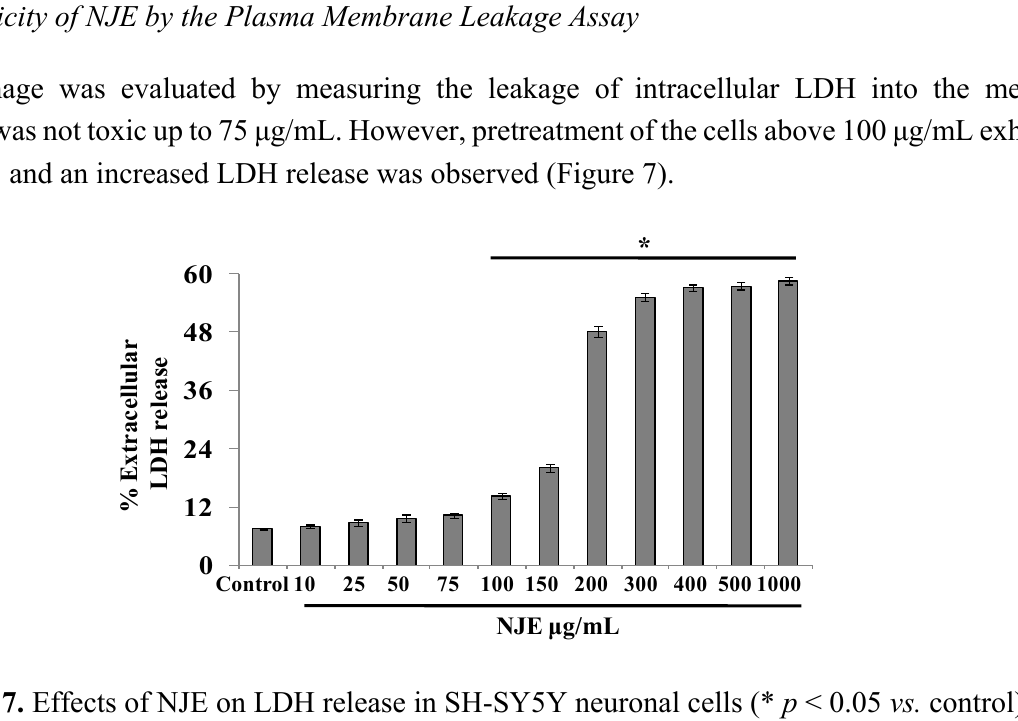
Figure 6. Inhibitory effects of NJE and gallic acid on AAPH-induced protein carbonyl formation. 3.4. Cytotoxicity of NJE by the Plasma Membrane Leakage Assay